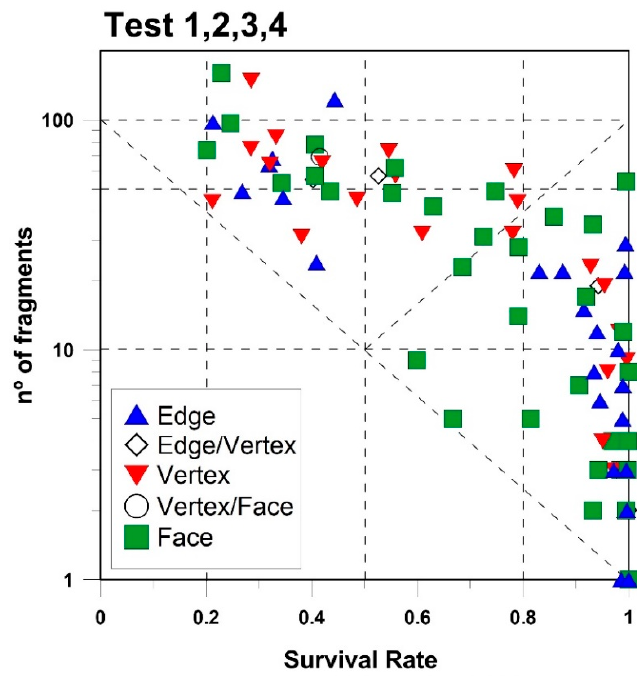
Figure 19. Survival rate versus number of fragments produced for each tested block combined with the block contact geometry.